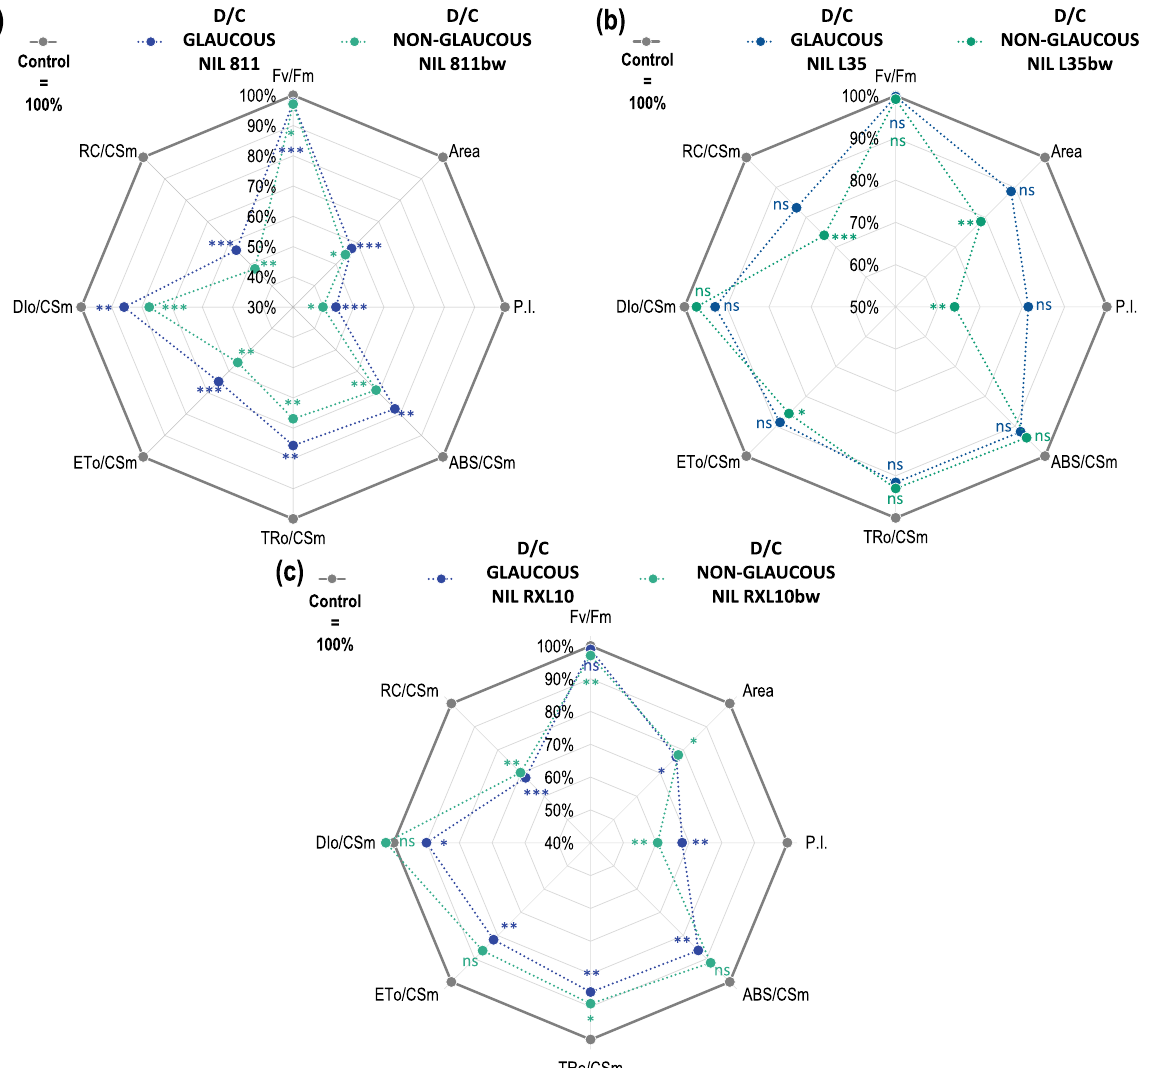
Figure 4. The drought to control percentage ratio (D/C) of chlorophyll a fluorescence kinetic parameters (F v / F m , Area, PI, ABS/CS m , TR o /CS m , ET o /CS m , DI o /CS m , RC/CS m ) in glaucous (811, L35, RXL10) and non-glaucous (811bw, L35bw, RXL10bw) near-isogenic rye lines. The grey line states for 100% of each line (control), D/C was calculated from the following formula: %CD/C = (D/C) × 100%, where C is the average value of the CF parameter for a given line in control conditions, D is the average value of the CF parameter for a given line under drought condition. The statistically significant differences between the means in control and drought were verified for P ≤ 0.001(***), P ≤ 0.01(**), P ≤ 0.05(*) according to Student’s test. ns not significant, F v /F m the maximum photochemical efficiency of photosystem II (PSII), Area the size of the electron acceptor field of PSII, PI the overall performance index of PSII, ABS/CS m the photon flux absorbed by antenna dye molecules, TR o /CS m the excitation energy trapped in PSII reaction centers, ET o /CS m the electron transport rate by PSII, DI o /CS m the energy dissipated from PSII, RC/CS m the density of active reaction